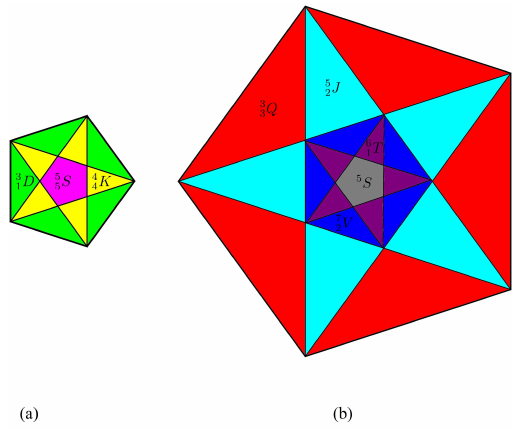
Figure 12. ( a ) The portions of atomic surface D corresponding to vertices 3 atomic surface C corresponding to vertices 3 inversion